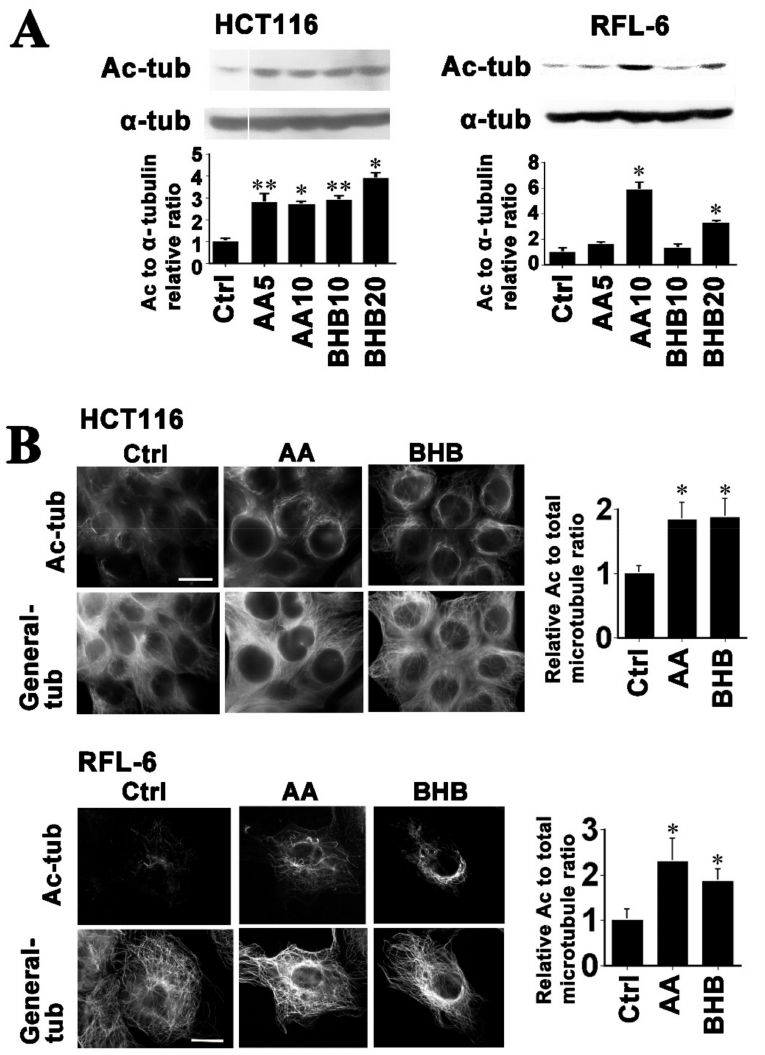
Figure 1. Ketone bodies have microtubule acetylation enhancement effects in RFL-6 and HCT116 cells. ( A ) HCT116 and RFL-6 cells were treated for three days with 5 or 10 mM AA, and 10 or 20 mM BHB, and whole cell lysates were then subjected to immunoblotting with the indicated primary antibodies (anti-acetylated α -tubulin: Ac-tub and anti- α -tubulin: α -tub). The relative Ac and α -tubulin ratios to the controls (Ctrl) by quantification are indicated in the graphs below respective blot images. Significant increases were detected in both cell types. ( B ) Cells were treated with 10 mM AA or, 20 mM BHB, cultured for three days, fixed, and stained for general- and acetylated-tubulin. In the immunofluorescence images, the upper panels indicate acetylated-tubulin (Ac-tub), the lower corresponding panels show general-tubulin (General-tub) staining. A perinuclear enhancement of microtubule acetylation was prominent following the ketone body treatments in both cell types. Scale bar, 10 µ m. The graphs show the quantified relative acetylated-tubulin/total-tubulin ratios to the control. Significant increases were detected in the ketone body-treated cells in both cell types. The asterisks and double asterisks indicate significant differences compared with the controls (Student’s t -test, * p < 0.01 and ** p < 0.05,